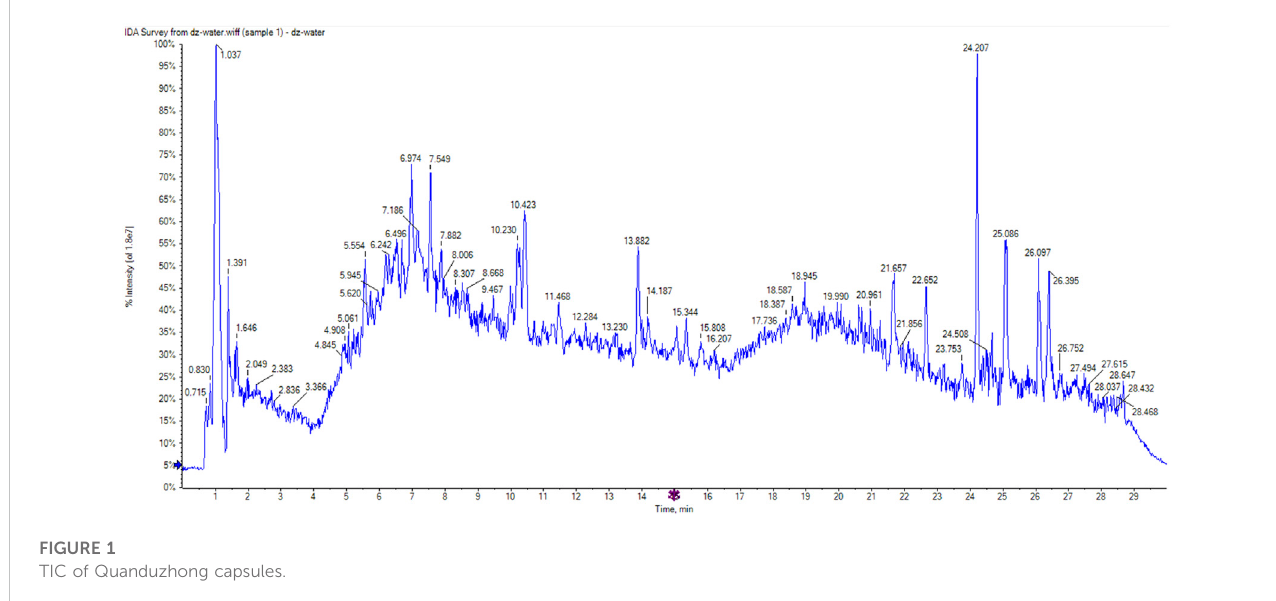
FIGURE 1 TIC of Quanduzhong capsules.